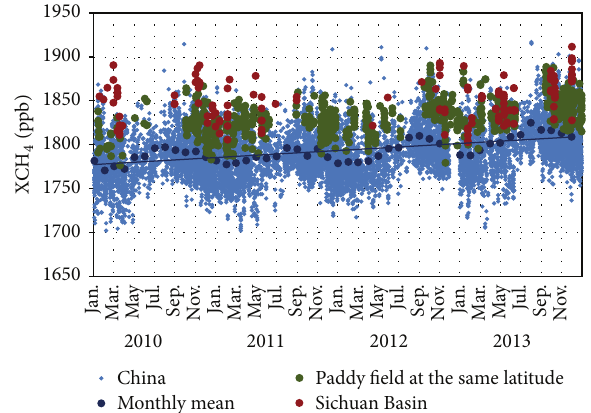
Figure 4: The seasonal variation of all the GOSAT XCH 4 data over Chinalandregion(lightbluedots),theSichuanBasin(reddots),and thericepaddyfields(darkgreendots)inthesamelatitudezonefrom January 2010 to December 2013. The dark blue dots are the monthly mean for land region and the blue line shows the corresponding trend from linear